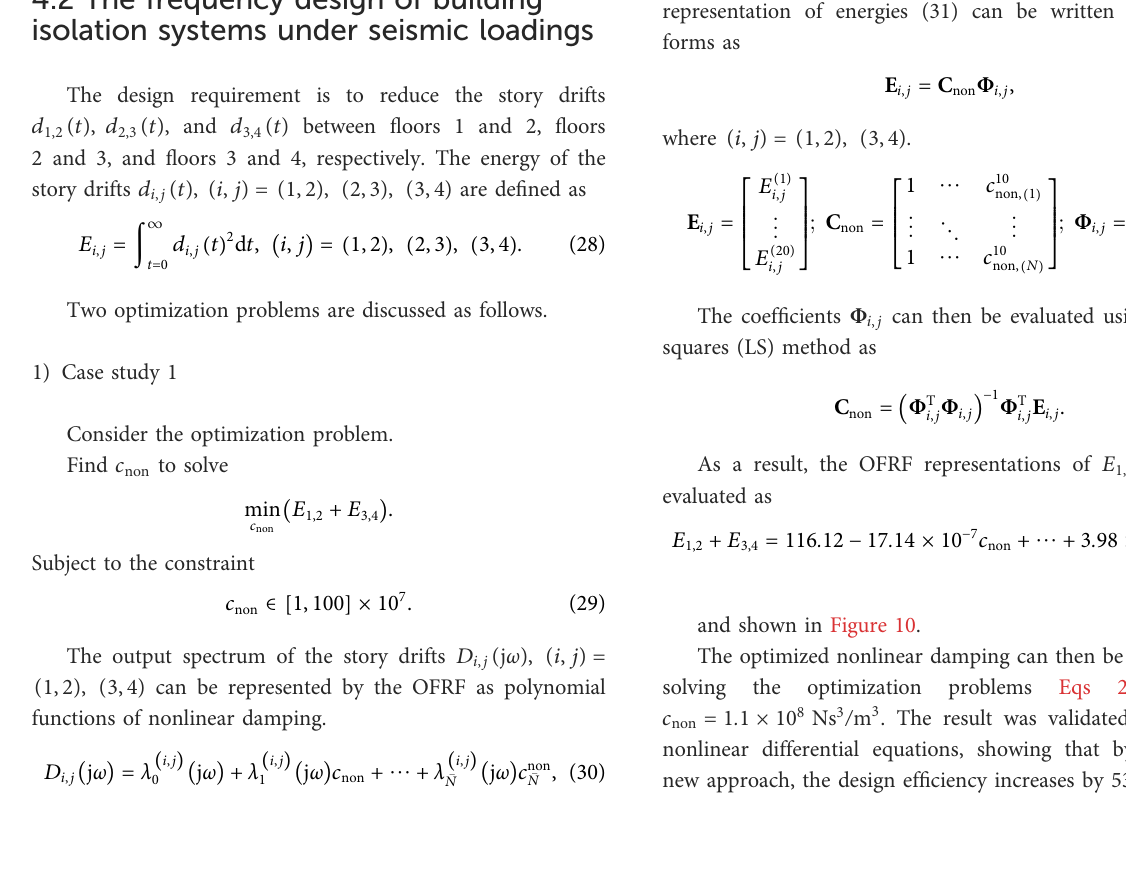
( j ω ) are the coef fi cients, and n